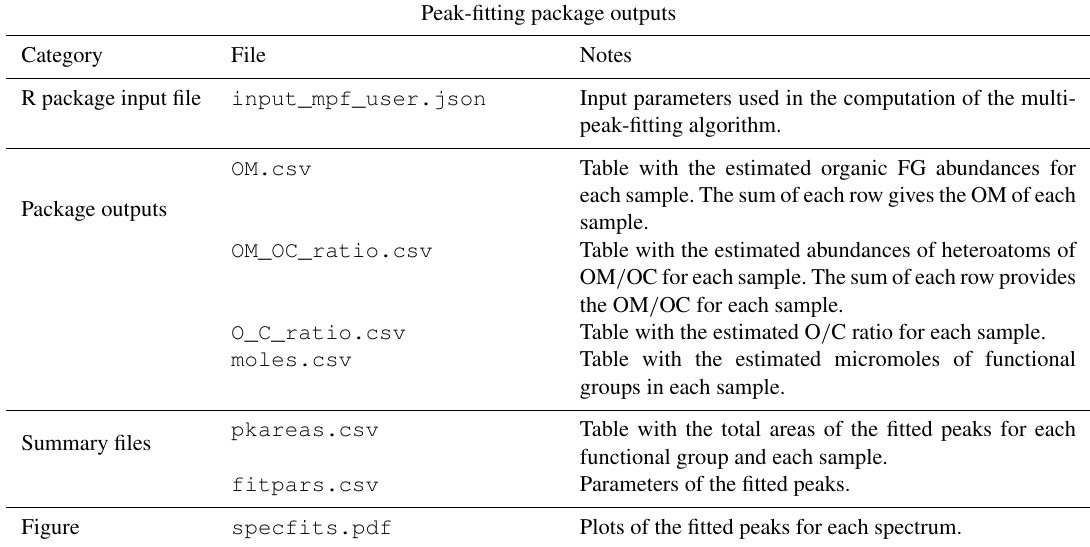
Table 3. List of outputs of the peak-fitting chemometric package.